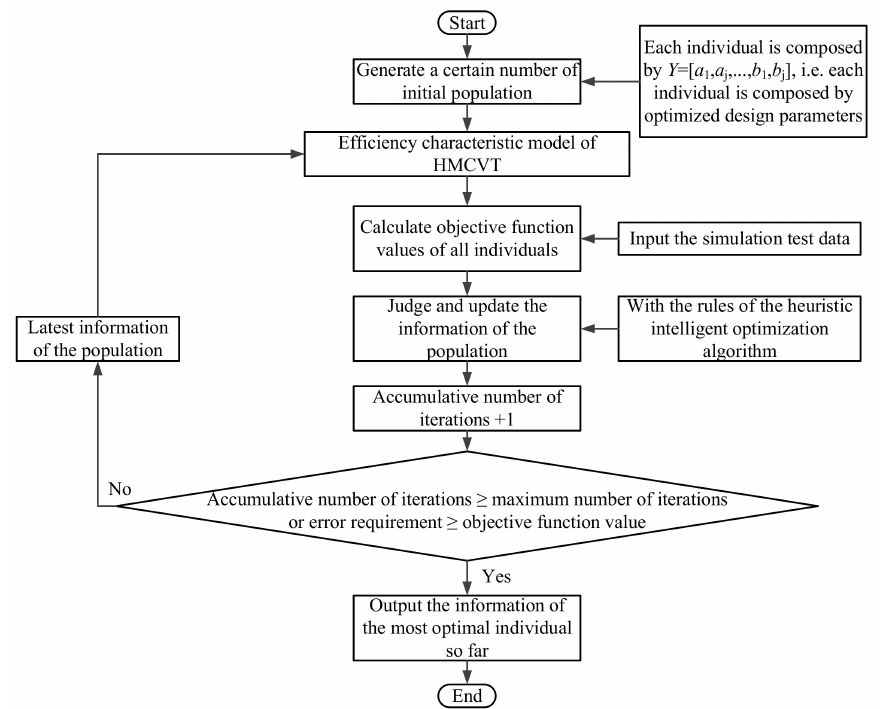
Figure 4. The flow chart of the proposed modeling